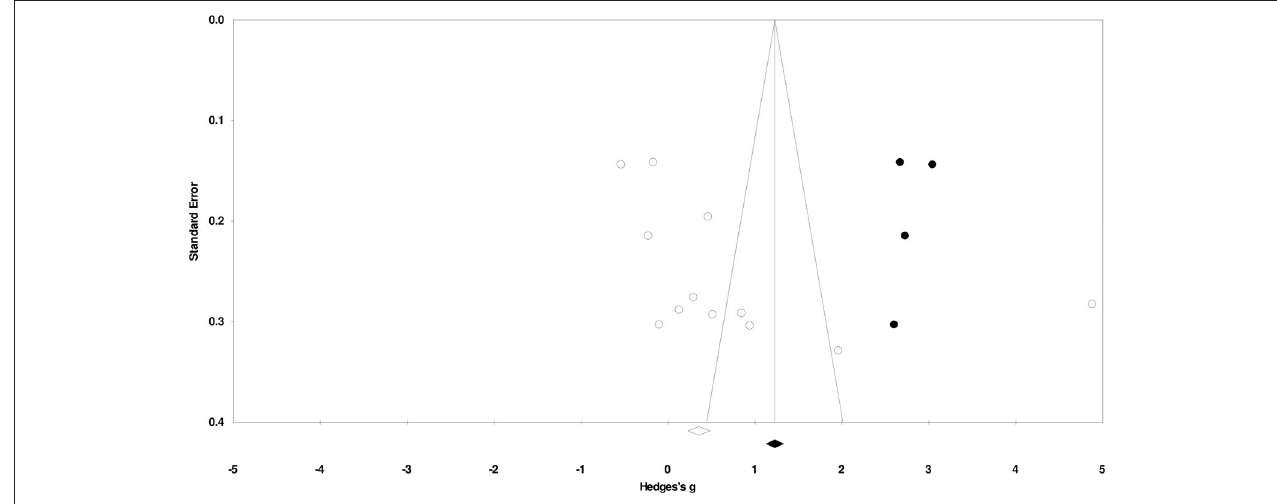
FIGURE 2 | Publication bias by Duval and Tweedy’s trim and fill method.